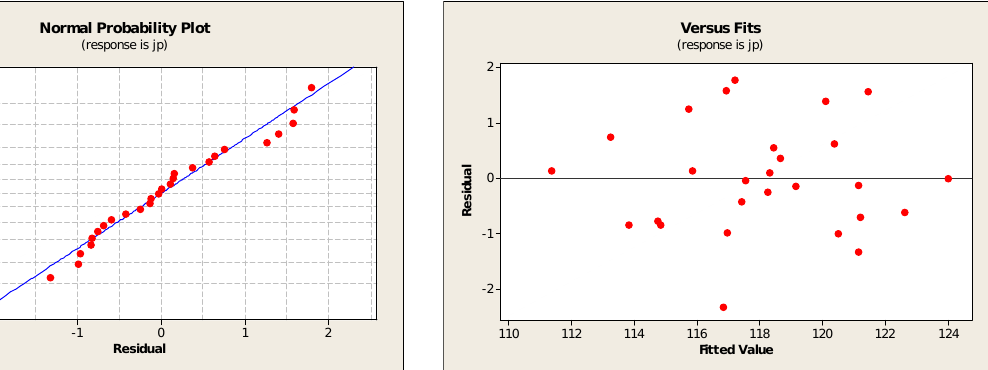
Fig. 1. Normal probability plot Fig. 2. Versus